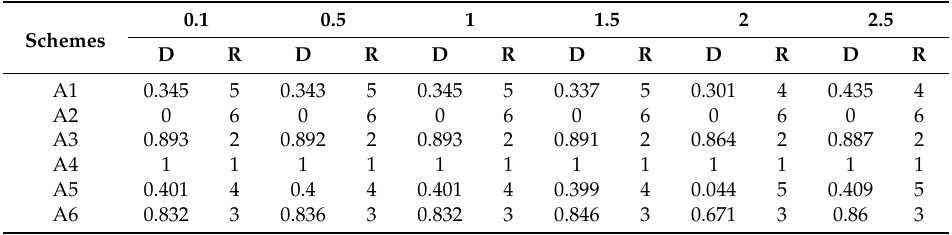
Table 9. Schemes with different recession coefficients Ranking